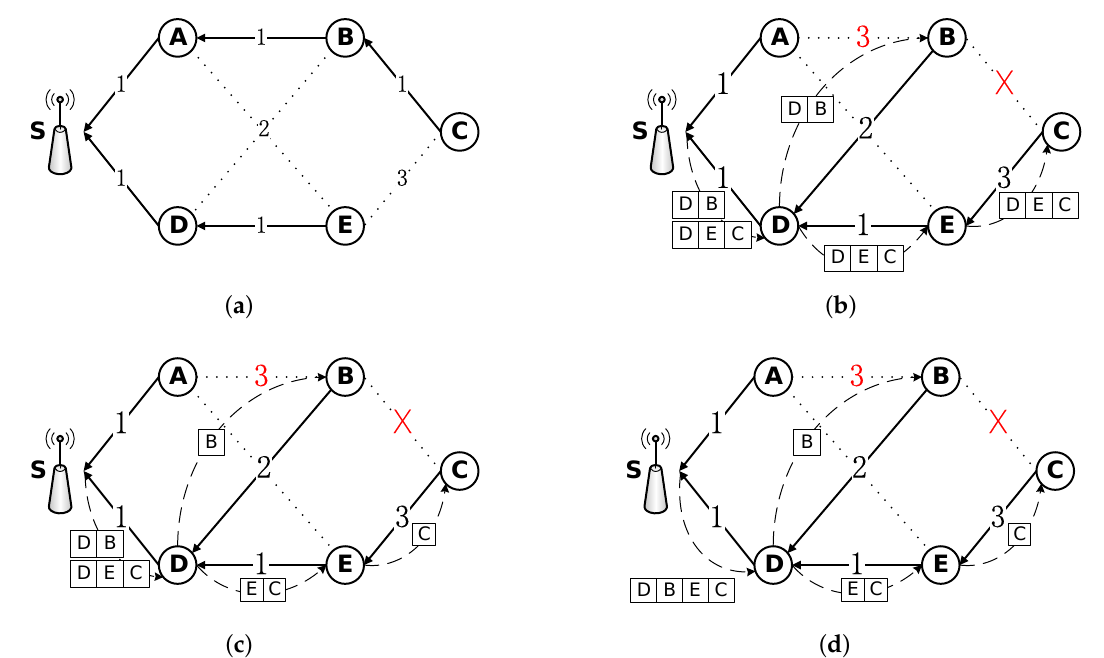
Figure 8. An example of routing path update process with three methods. The directed links represent the information transmission flow. The value on links (including dashed lines) indicate the transmission cost and nodes select the routing paths with the minimum total transmission cost. The dashed lines with arrows are the transmission paths of update packets. ( a ) A simple network topology; ( b ) sending update packets individually to nodeB and node C ; ( c ) sending update packets with a decreased packet’s length; and ( d ) sending compressed update packets with a decreased packet’s